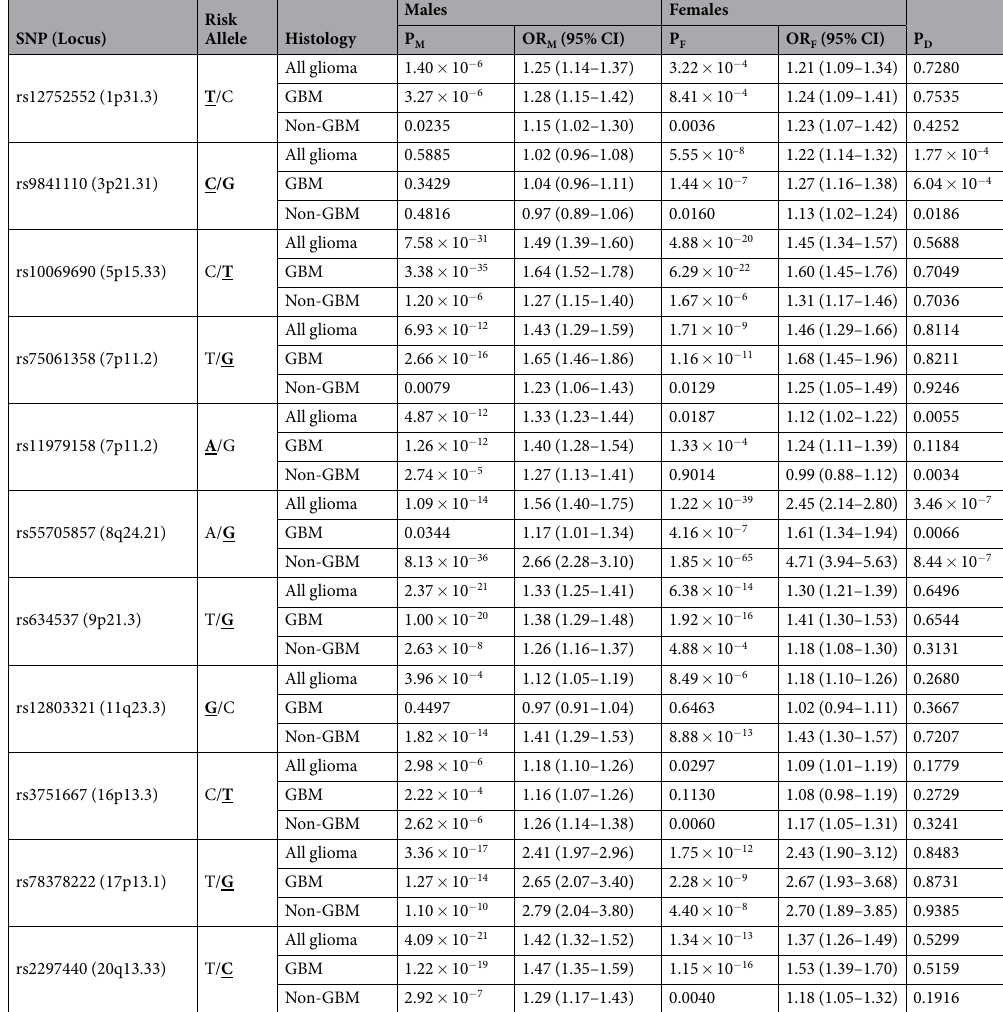
Table 2. Previously identified glioma risk loci and histology-specific odds ratios (OR) and 95% confidence intervals (95% CI) stratified by